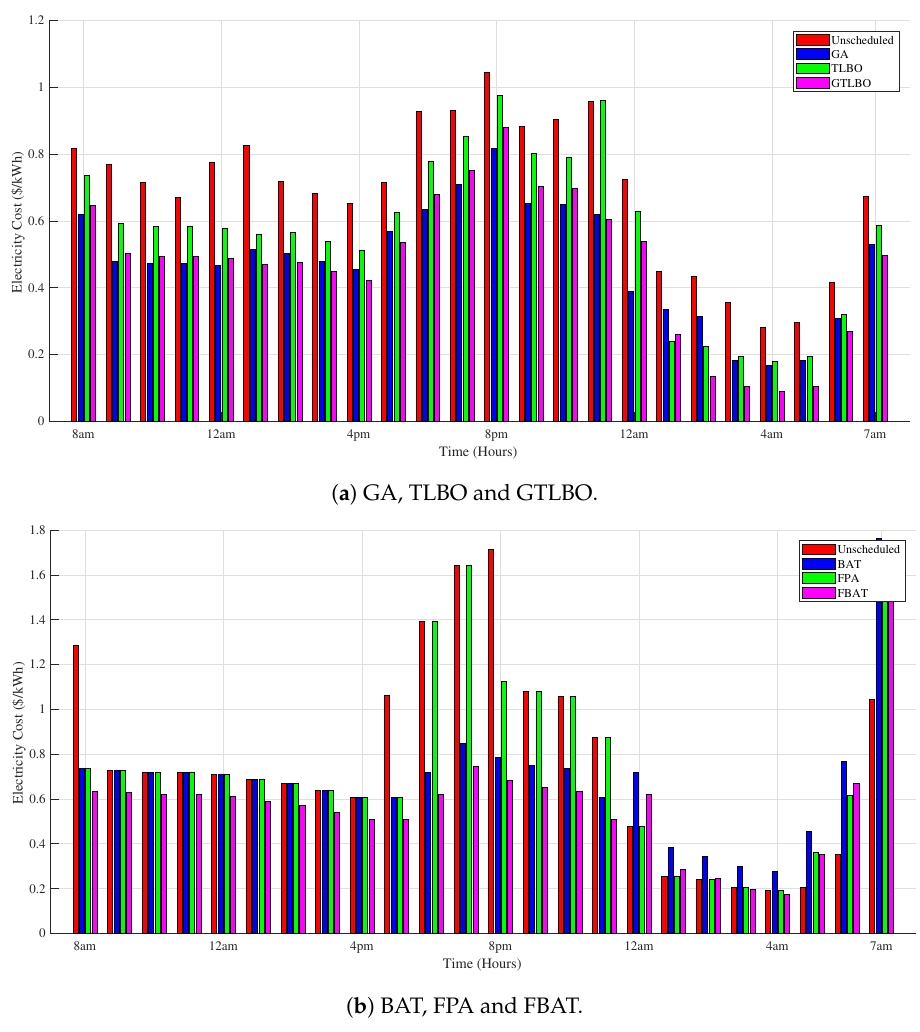
( b ) BAT, FPA and FBAT. Figure 9. Hourly electricity cost of appliances. ( a ) GA, TLBO and GTLBO;